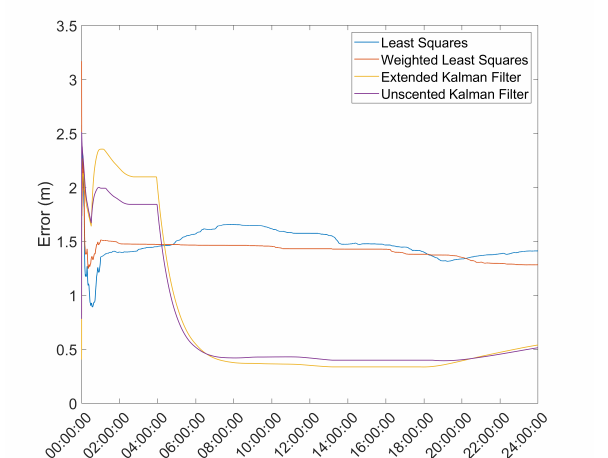
Figure 6. Effect of a 1 σ threshold on the mean error over time for the reference station antenna with no Hatch Filter.